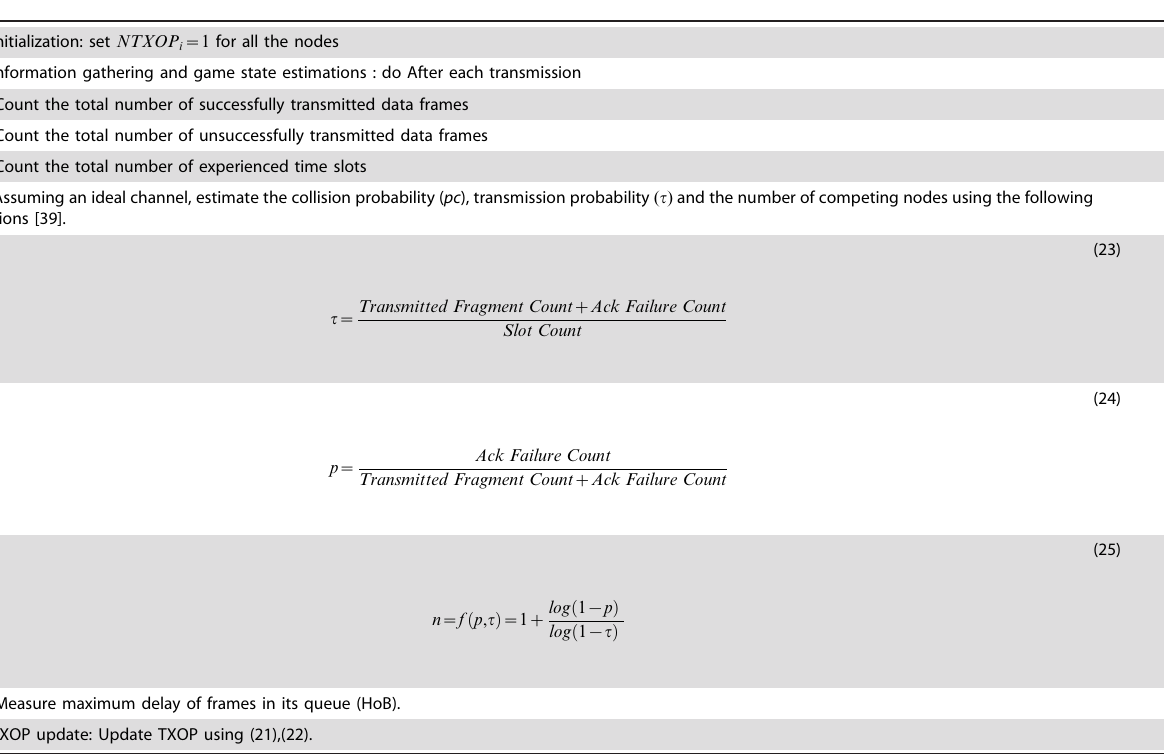
Table 1. The GTXOP